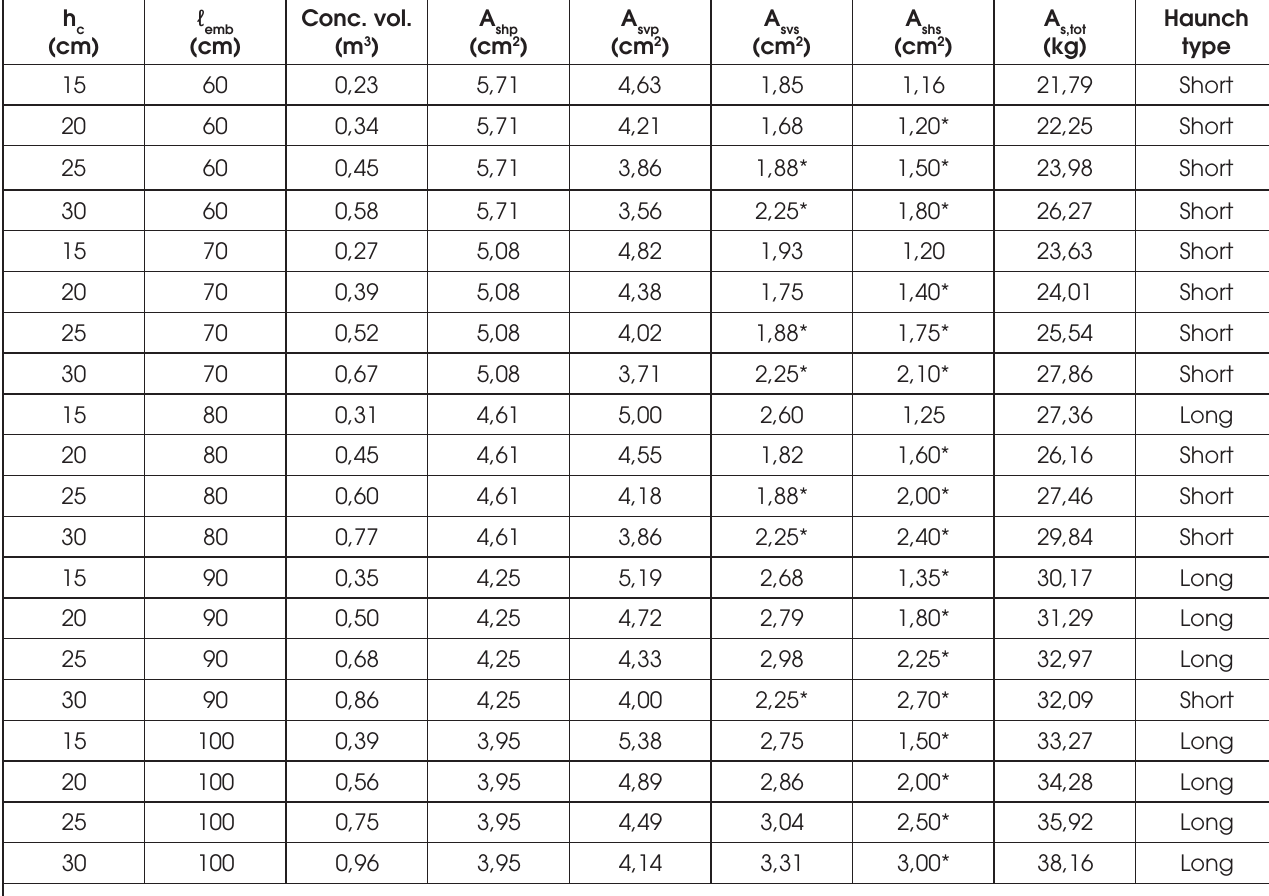
Influence of modification of the geometric parameters for the problem type